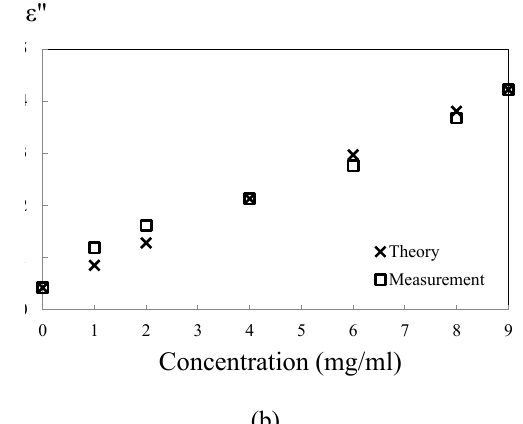
Figure 7: Theoretical and measured values of the dielectric permittivity for different NaCl aqueous solutions at 5.9 GHz: (a) real part ε’, (b) imaginary part